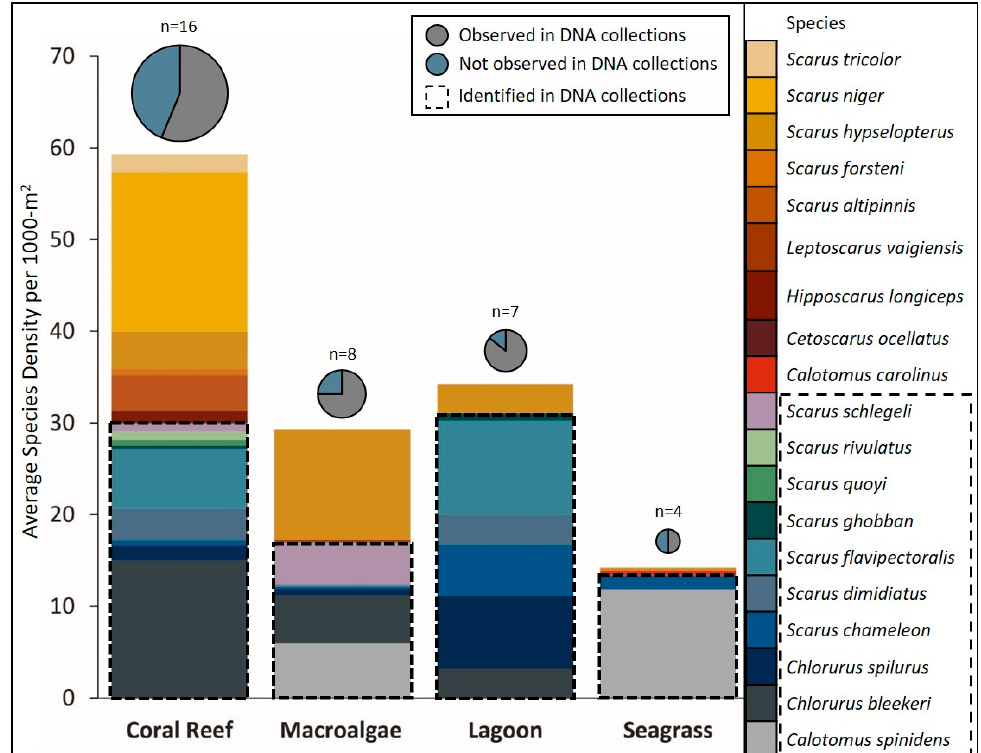
Figure 3. Average density of adult parrotfish species observed in visual census surveys within each habitat type: the colours represent different species. Dashed boxes on each bar outline the species identified in DNA analysis from juvenile collections in non-reef habitats. Pie graphs represent the total number of species observed in each habitat type, separated by whether the species were observed in DNA collections of juveniles in non-reef habitats (grey) or not observed in collections (blue). Size of the pie graph portrays total number (n) of species observed as adults within each habitat type. habitats were different from those for adults observed in UVC surveys of these habitats (Figure 4).